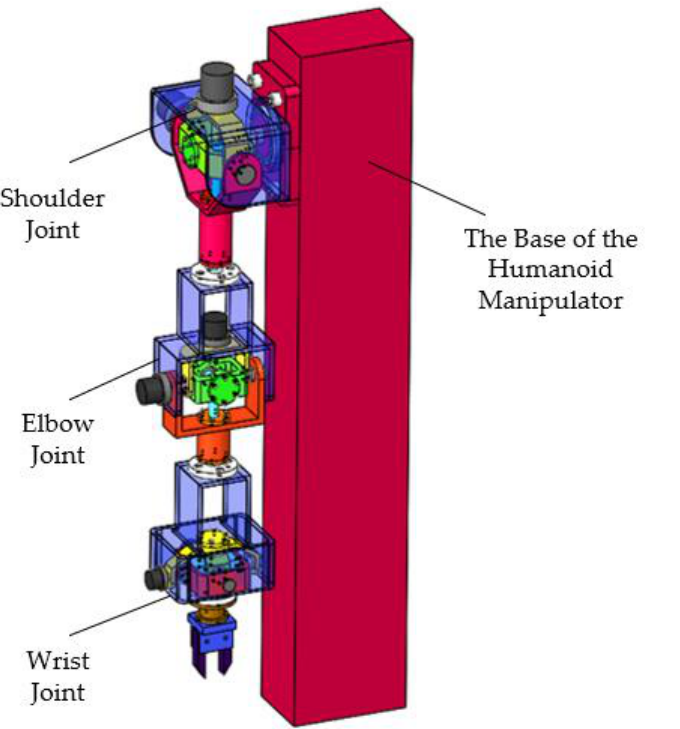
Figure 3. The structural model of the humanoid manipulator.